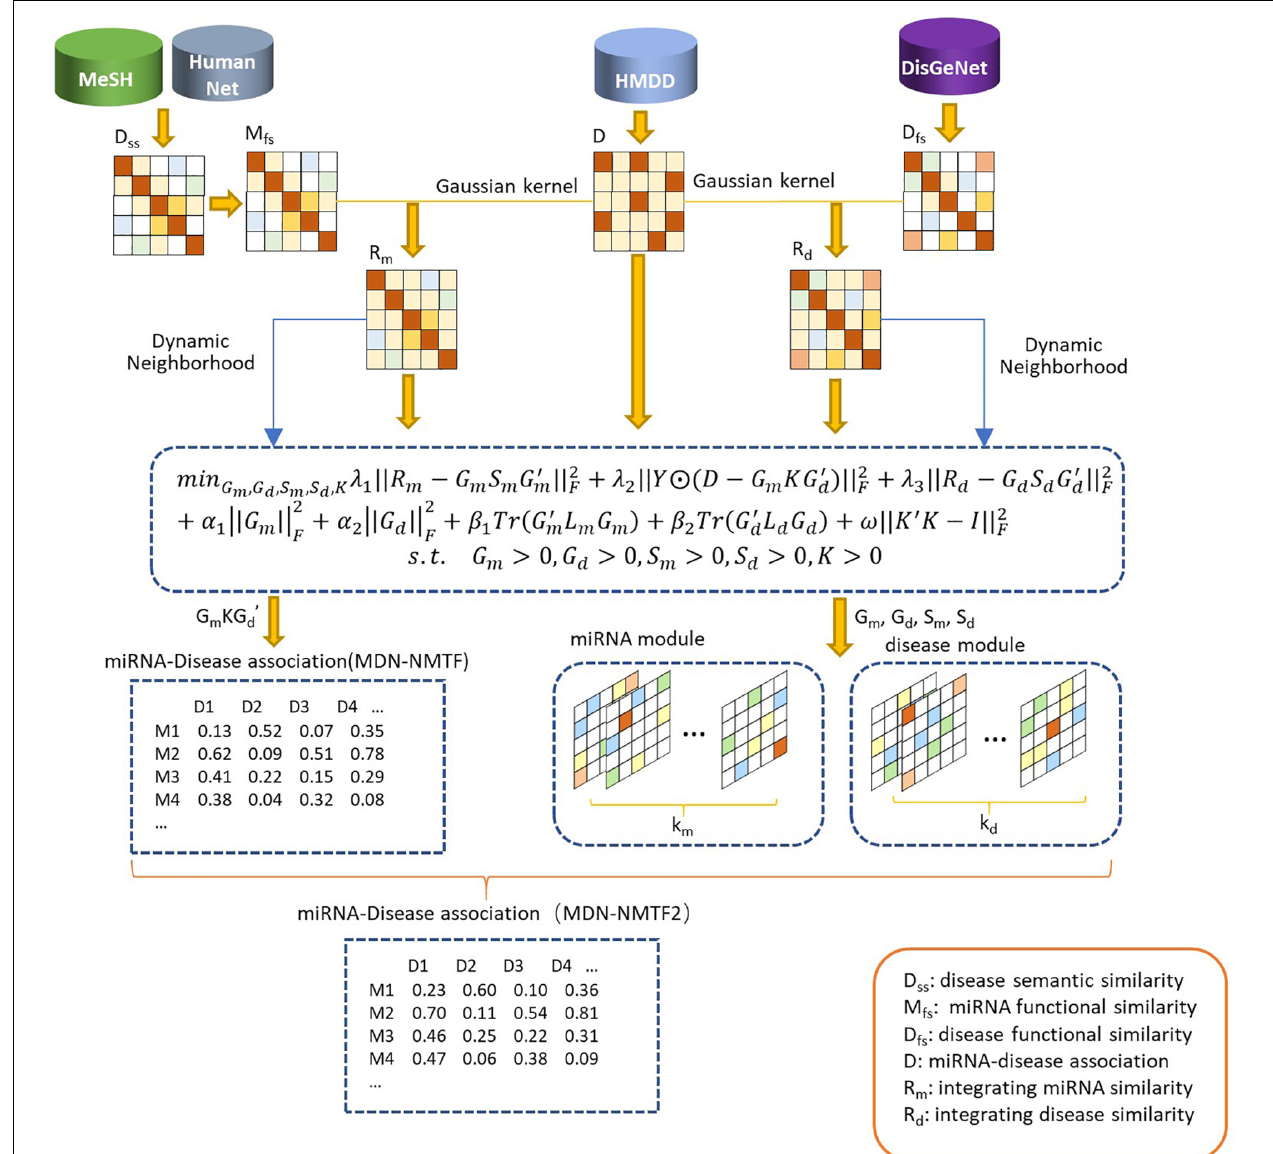
FIGURE 1 | The flowchart of MDN-NMTF and MDN-NMTF2 to predict miRNA-disease association. The MDN-NMTF model takes four steps to predict miRNA-disease associations: building the similarity networks, learning feature representation for miRNA and diseases; reconstructing the miRNA-disease association network, predicting miRNA-disease associations. MDN-NMTF2 is an extended version of MDN-NMTF. It divides the miRNAs and diseases into several modules on the basis of the representation vectors learned by MDN-NMTF. MDN-NMTF2 calculates the similarity of two miRNAs or two diseases based on the module they belong to and infers the novel miRNA-disease associations from similar miRNAs or diseases in the same